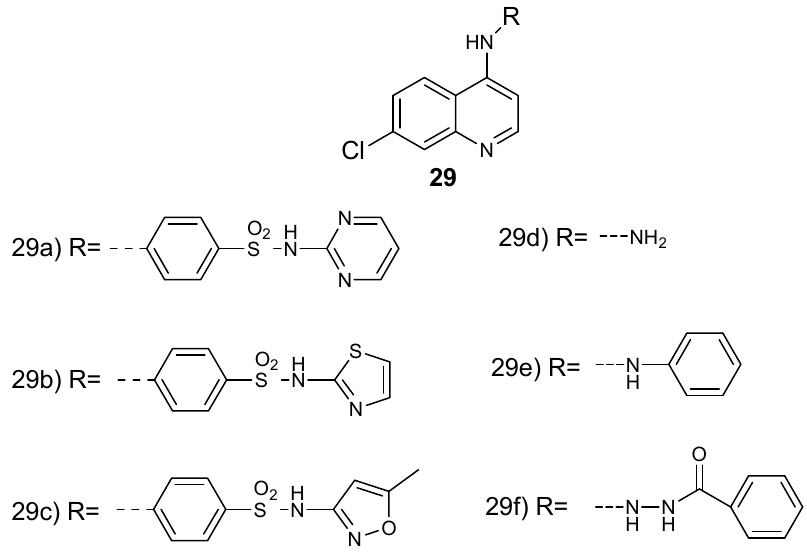
Figure 13. 4-aminoquinoline–sulfonamide and hydrazine hybrids 29a – f.